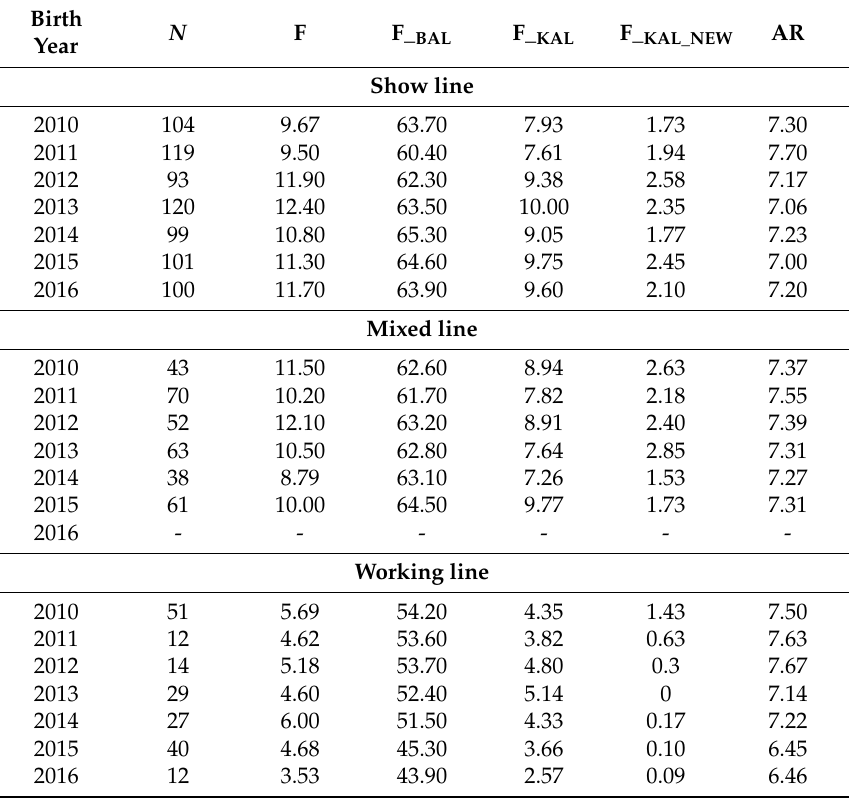
Table 4. Ancestral inbreeding coe ffi cients in subpopulations